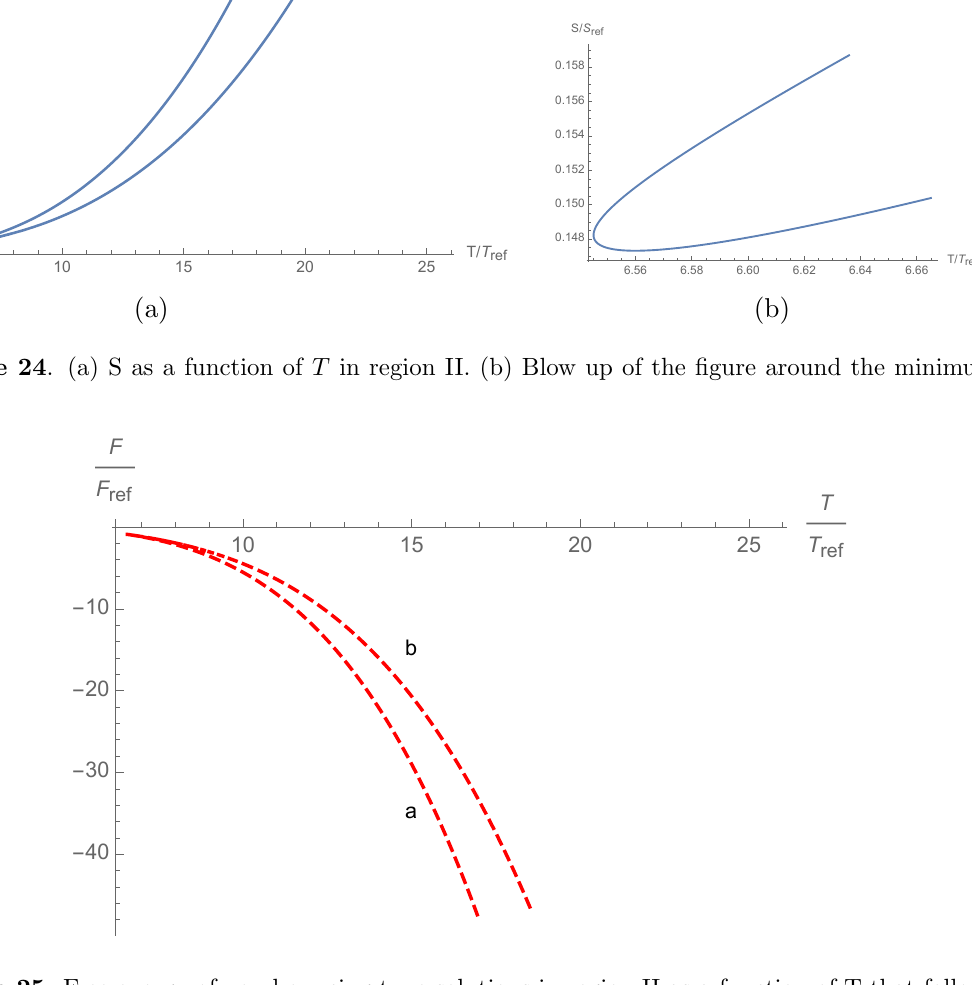
Figure 25 . Free energy of non-bouncing type solutions in region II as a function of T that follows from the potential in (cid:12)gure 18. Latin letters label the di(cid:11)erent branches shown in (cid:12)gure